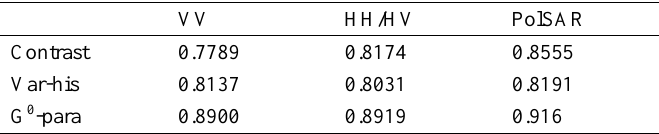
Table 1. The AUC of G 0 distribution texture parameters in SAR data with different polarizations